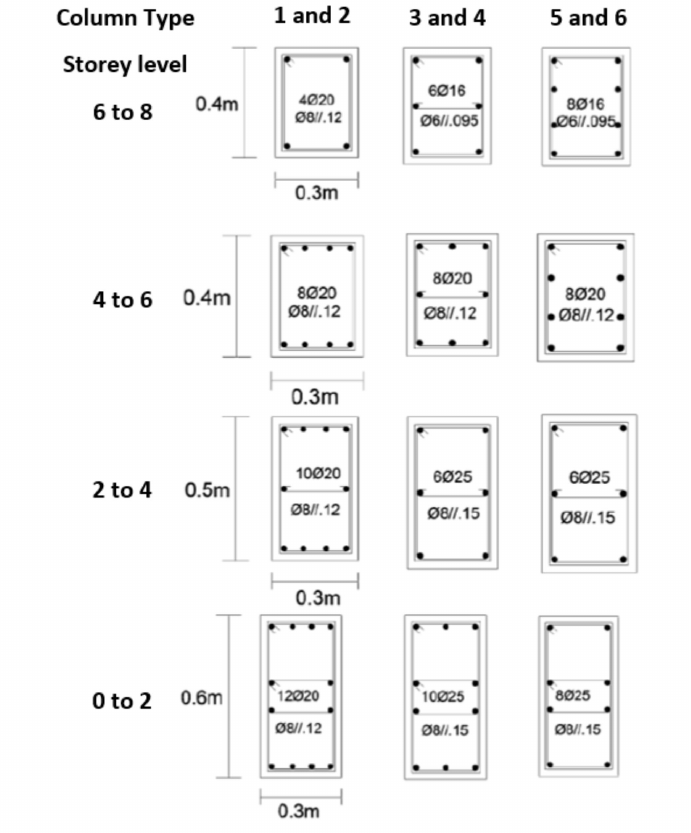
Figure 25. Case study: columns’